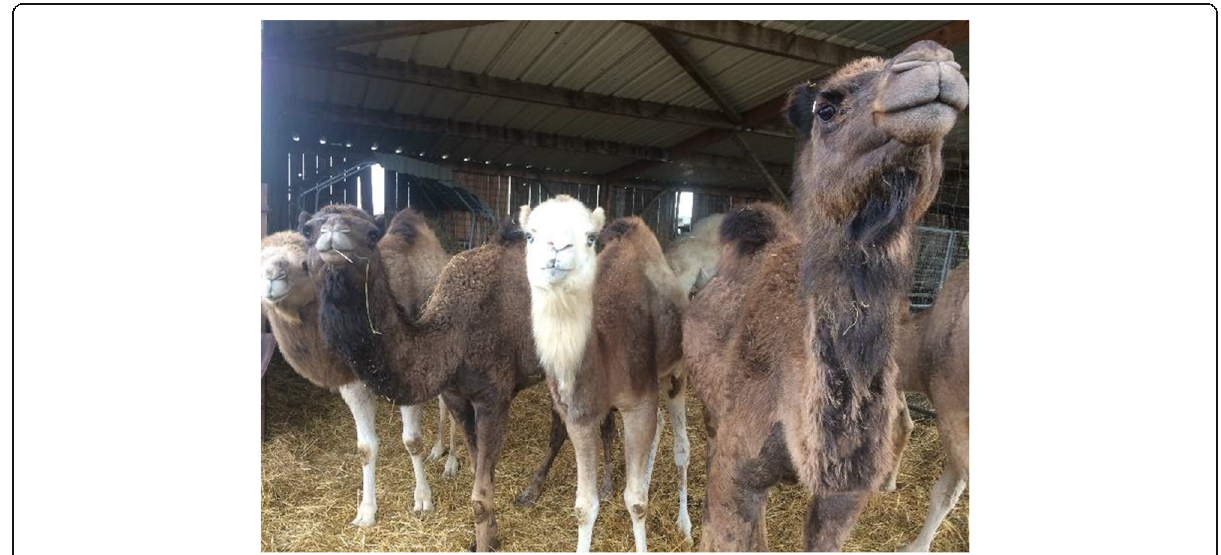
Fig. 14 Camel farm for tourism attraction, Feignies, France (Ph. B. Faye)